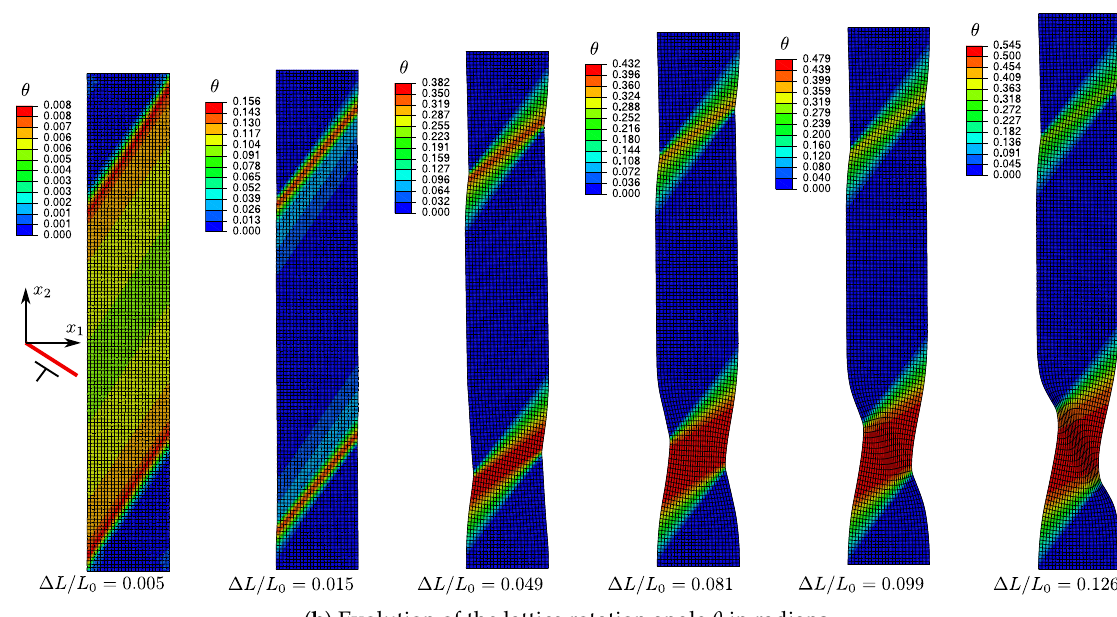
Figure 12. Evolution of the plastic slip variable γ and lattice rotation angle θ at different nominal tensile strains predicted by conventional CP ( l en = l dis =